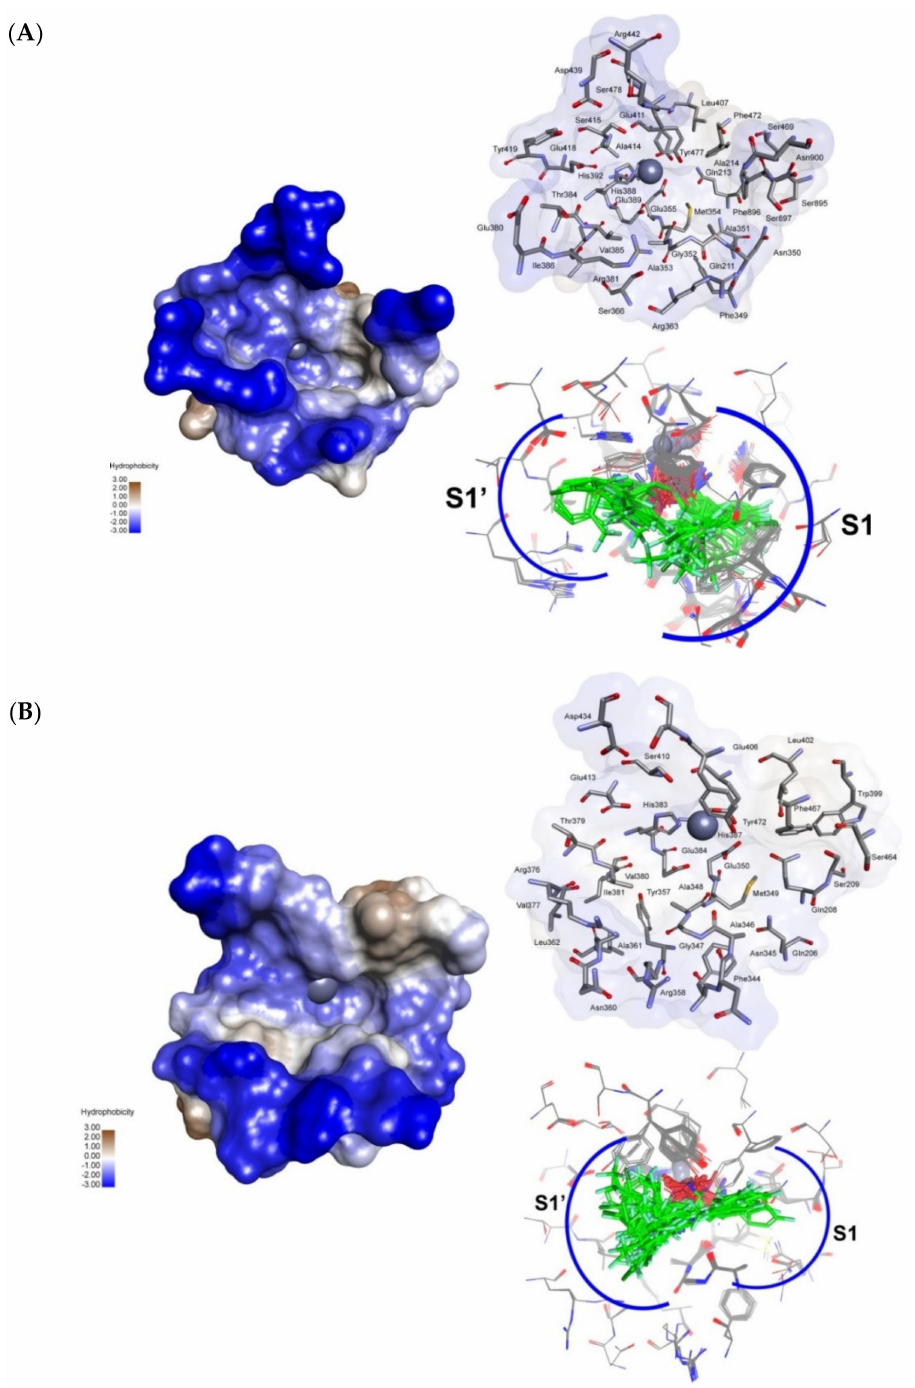
Figure 1. Comparison of hAPN ( A ) and pAPN ( B ) in terms of surfaces of the enzymes, architectures of their binding sites and positioning of all the studied inhibitors (of both R and S forms) in their active sites. Red color is assigned to oxygen atoms from the phosphonate moiety, the amine group is colored blue, the carbon and chlorine atoms are in green and the fluorine atoms are marked as light blue. The zinc ions are shown as the